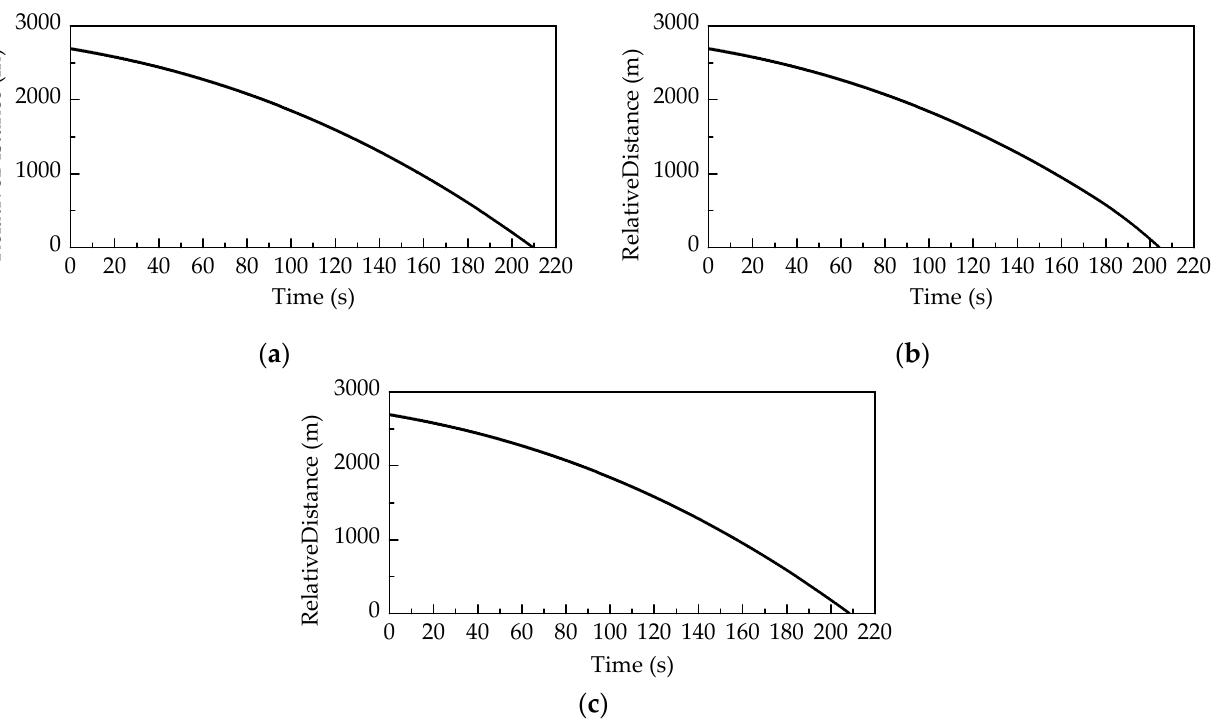
Figure 12. The average relative distance of 100 Monte Carlo runs in the scenario that the evader plays ( a ) without time delay; ( b ) without compensation for time delay; and ( c ) with compensation for time delay.